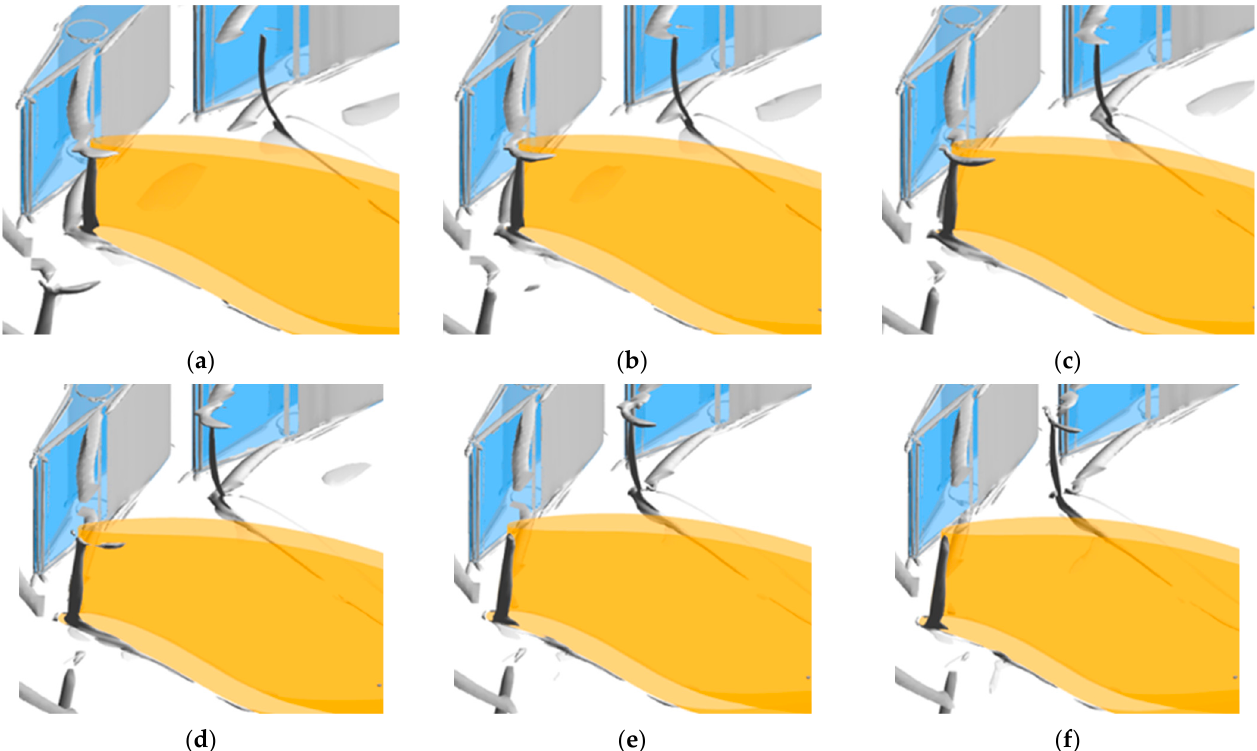
Figure 12. Progression of leakage vortex during runner rotation at part load: ( a ) T 0 ; ( b ) T 0 + 1/5 of X°; ( c ) T 0 + 2/5 of X°; ( d ) T 0 + 3/5 of X°; ( e ) T 0 + 4/5 of X°; ( f ) T 0 + X°.